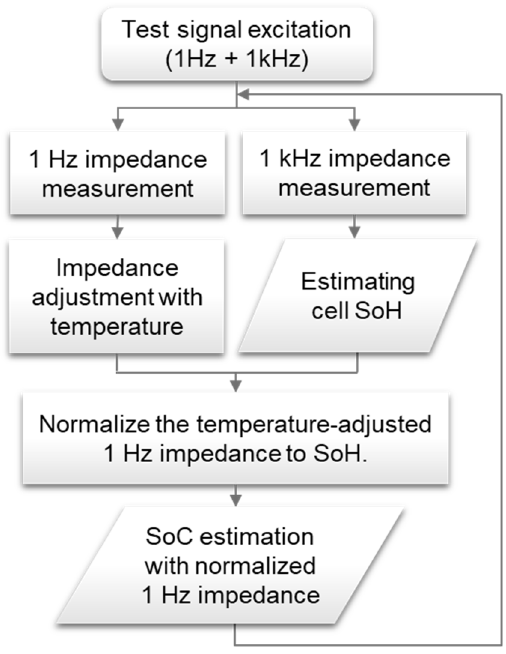
Figure 2. Flow chart showing the cell state estimation process.